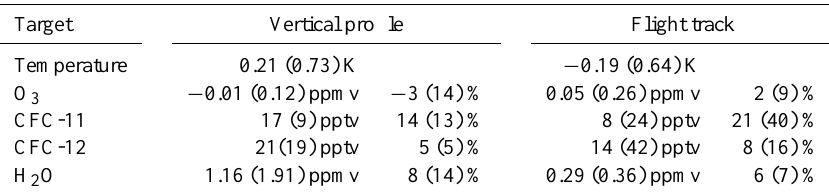
Table 4. Mean differences and sample standard deviations (1 σ , in parentheses) of the mean differences between MIPAS-STR and in-situ results for profile comparison and comparison along flight track.